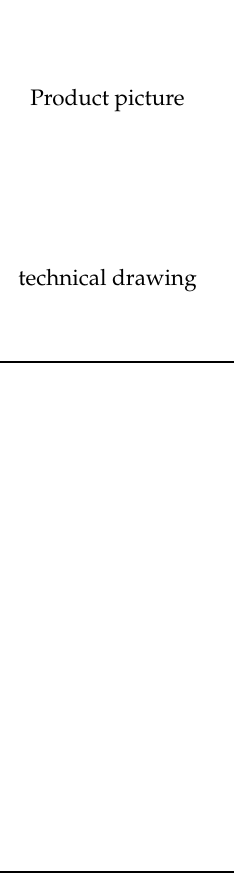
Table 4. Results of the appearance evaluation by experts.